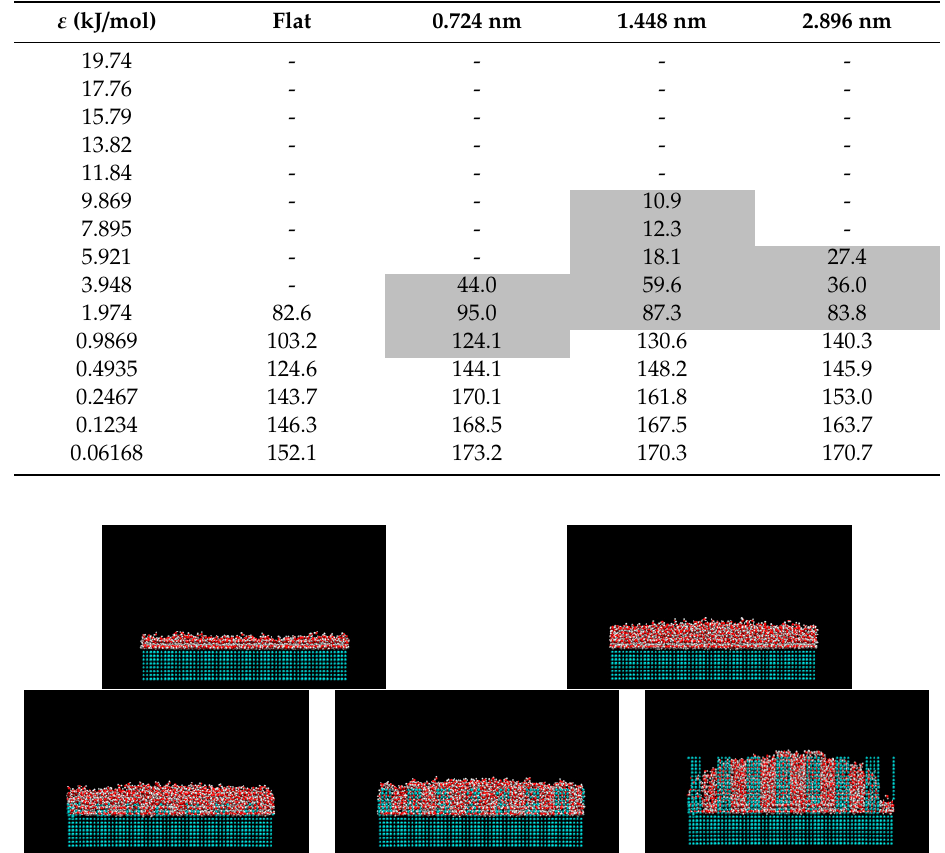
Table 3. Contact angle and wetting state of 6-nm droplets on each surface. The numbers on the gray background correspond to the Wenzel state, whereas the numbers without background correspond to the Cassie state.